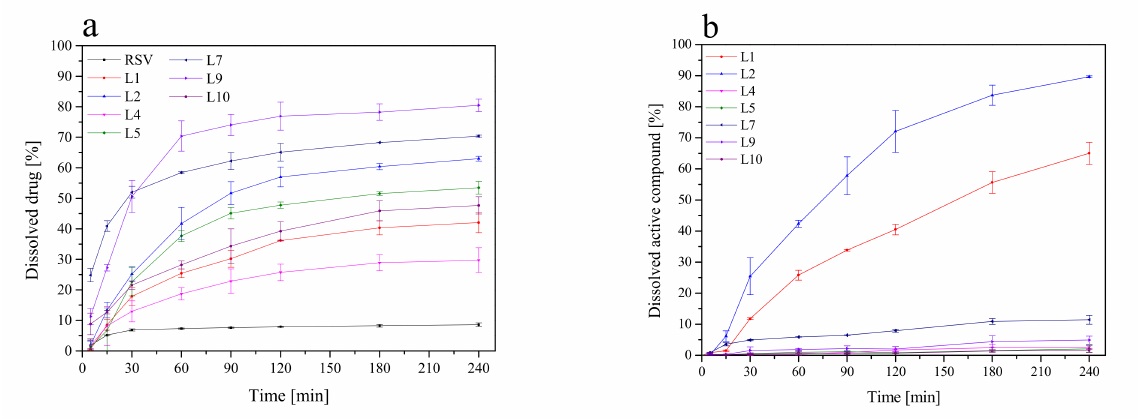
Figure 2. Dissolution profiles of the RSV ( a ) and the emodin ( b ) from lyophilized extracts at pH ~